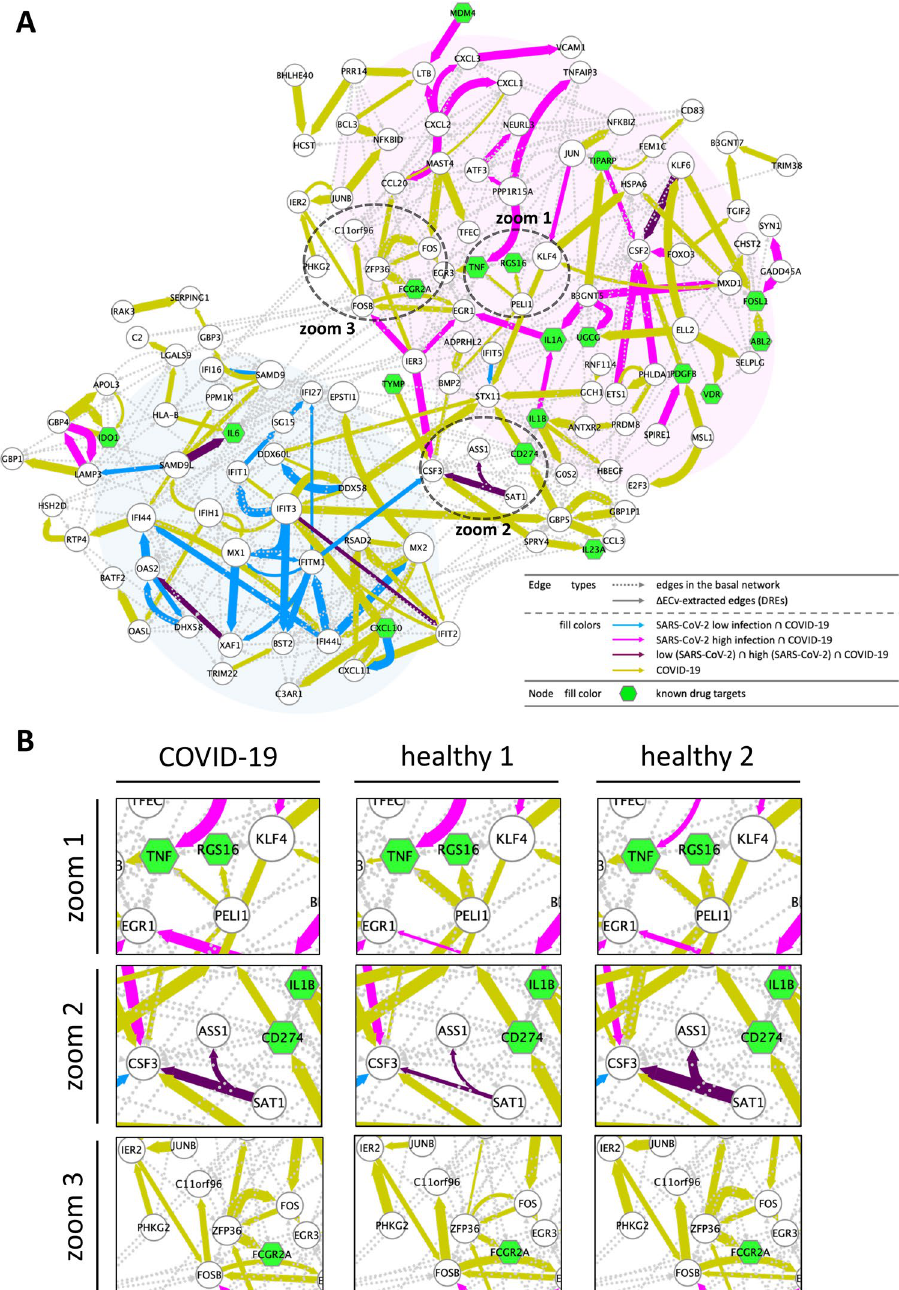
Figure 6. Establishment of the COVID-19 patient-specific individual network. ( A ) The COVID-19 patient- specific network with RCs represented by edge sizes. The network comprises 127 nodes and 412 edges (including 245 basal edges). The colored solid edges represent DREs; SARS-CoV-2 (high MOI: 2) ∩ COVID-19- perturbed (magenta), SARS-CoV-2 (low MOI: 0.2) ∩ COVID-19-perturbed (blue), SARS-CoV-2 (high MOI: 2) ∩ SARS-CoV-2 (low MOI: 0.2) ∩ COVID-19-perturbed (purple), COVID-19-perturbed exclusive edges (yellow). The dotted edges represent the basal edges (gray). The nodes (green) represents the known drug target genes (Supplementary Table S2). The node size stands for the extent of outdegree. ( B ) Zoomed regions indicated in Fig. 6A for three individuals (healthy 1, healthy 2, and the patient with COVID-19). RCs are represented as edge sizes to show individual